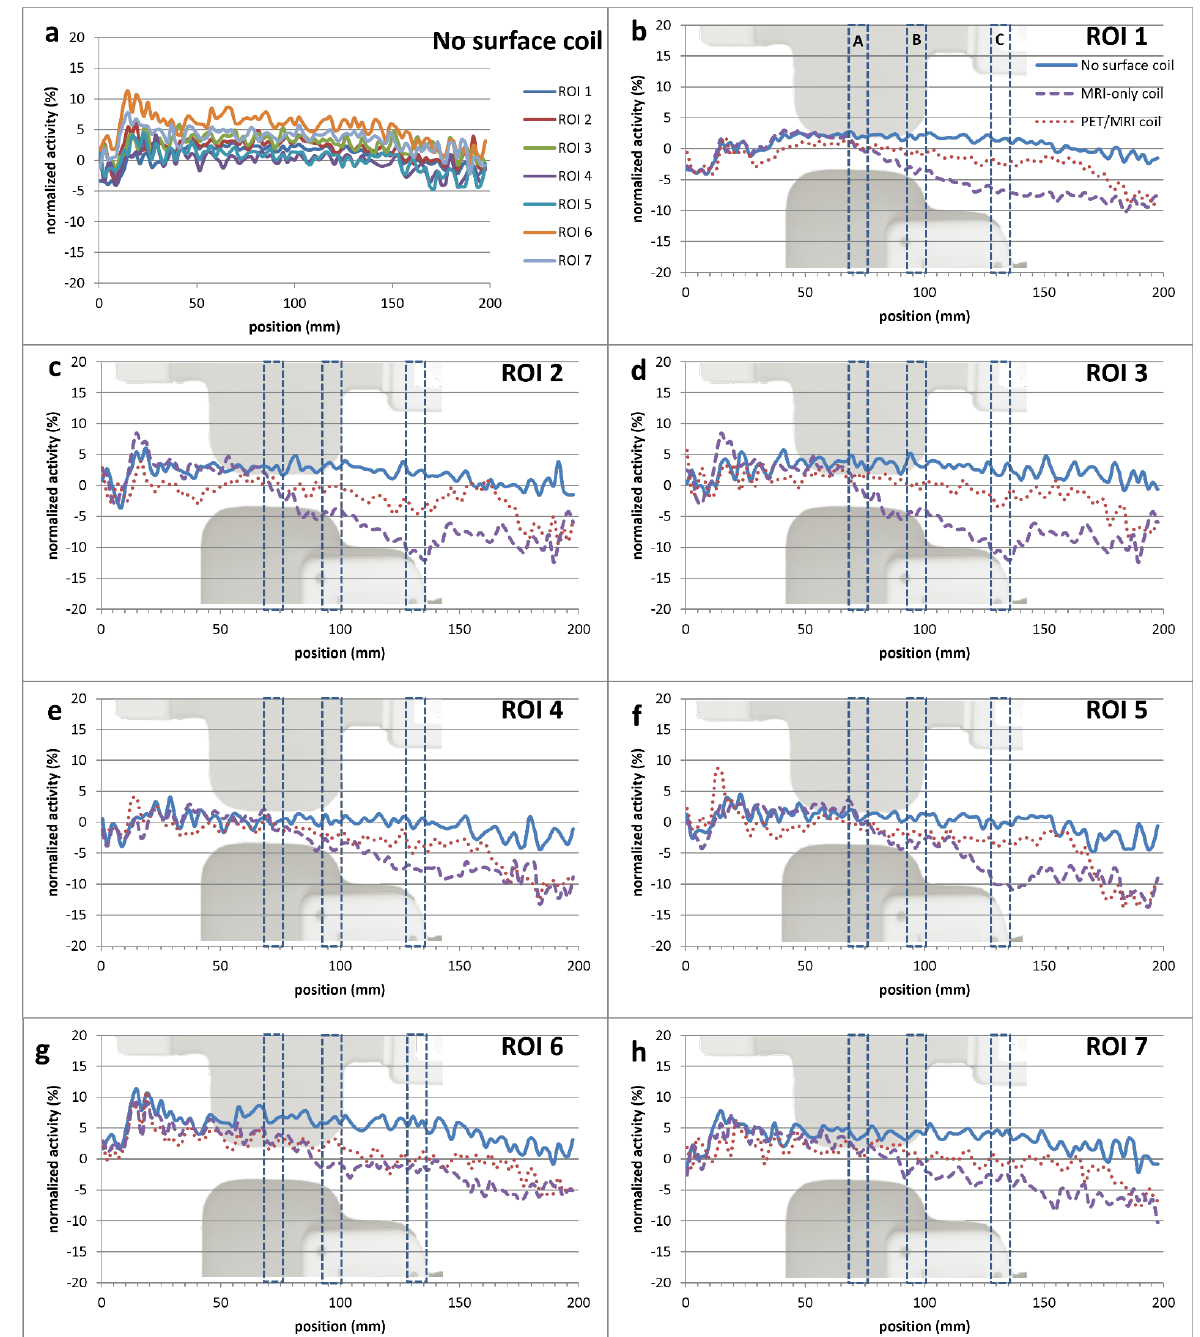
Figure 4. The normalized activity throughout the phantom for each of the ROIs. The approximate position of the PET/MRI coil (top) and MRI-only coil (bottom) can be seen in the background. ( a ) The variation in the no surface coil configuration activity in the seven ROIs. ( b – h ) The normalized activities of the no surface coil configuration as well as with the PET/MRI and MRI-only coil. The highest deviation from the no surface coil configuration for each ROI is seen in the region of the electronic housing. In all ROIs the PET/MRI coil shows less deviation from the no surface coil configuration as compared to the MRI-only coil.